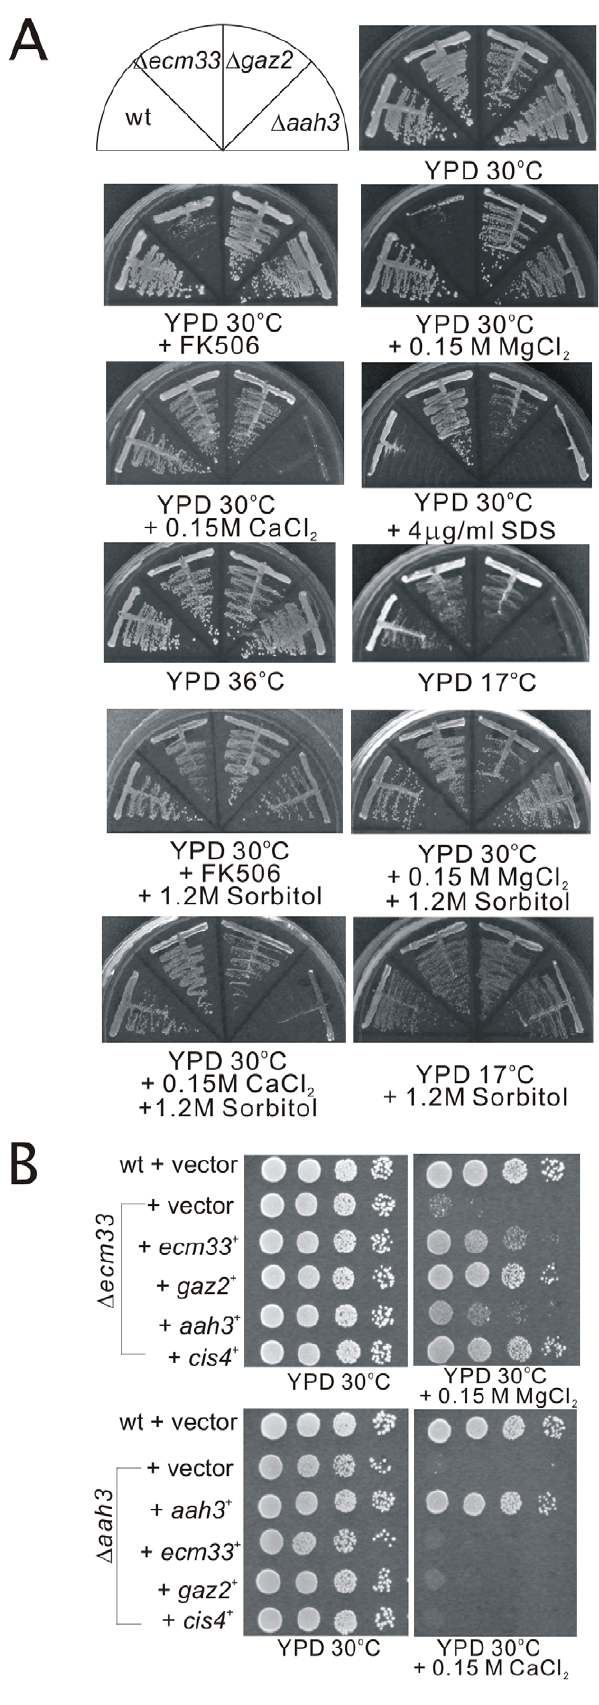
Figure 2. The D ecm33 , D aah3 , and D gaz2 mutants displayed distinct phenotypes. (A) Phenotypes of the D ecm33 , D aah3 , and D gaz2 mutants. Upper panel, Cells were streaked onto each plate as indicated, and then incubated at 30 u C for 4 days, at 36 u C for 3 days or at 17 u C for 7 days. Lower panel, MgCl 2 -sensitive and FK506-sensitive phenotypes of D ecm33 and cold temperature-sensitive phenotype of D aah3 were osmoremedial, whereas CaCl 2 -sensitive phenotype of D aah3 was not. Cells were streaked onto each plate as indicated, and then incubated at 30 u C for 4 days or at 17 u C for 7 days. (B) Effects of overexpression of the gaz2 + , aah3 + , and cis4 + genes on the phenotypes of D ecm33 , and effects of overexpression of the ecm33 + , gaz2 + , and cis4 + genes on the phenotypes of D aah3 . Wild-type cells, D ecm33 or D aah3 cells transformed with a control vector or the vector containing ecm33 + , gaz2 + , aah3 + , and cis4 + were spotted onto YPD plates or YPD plus 0.15 M MgCl 2 and incubated at 30 u C for 4